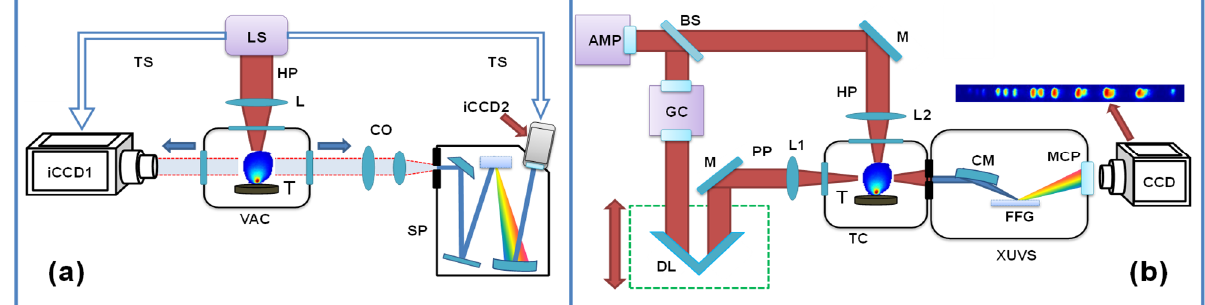
Figure 1. Schematic of the experimental arrangement for ( a ) LIBS and spatial dynamic measurements of plasma and ( b ) HHG. ( a ) LS: laser source, HP: 150 ps heating pulses, L: focusing lens, VAC: vacuum chamber for target (T), TS: trigger signal, SP: spectrometer, iCCD1 and iCCD2: gated intensified CCD cameras for imaging and spectra registration, CO: collection optics. ( b ) AMP: amplifier, BS: beam splitter, GC: grating compressor, M: mirrors, DL: optical delay line, L1 and L2: focusing lenses for uncompressed heating pulses (HP) and probe pulses (PP), TC: target chamber, T: target, XUVS: XUV spectrometer, CM: cylindrical mirror, FFG: flat-field grating, MCP: microchannel plate, CCD: charge-coupled camera.